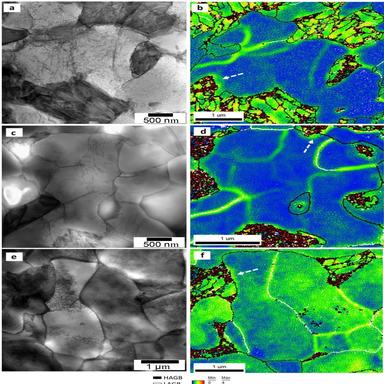
TEM images after UFH treatment for a) 0.2 s, c) 1.5 s and e) 30 s; KAM maps for b) 0.2 s, d) 1.5 s and f) 30 s obtained from the TKD analysis. White dashed arrows indicate the increase in misorientation in the ferritic matrix due to the martensite formation (HAGBs in black, LAGBs in white).